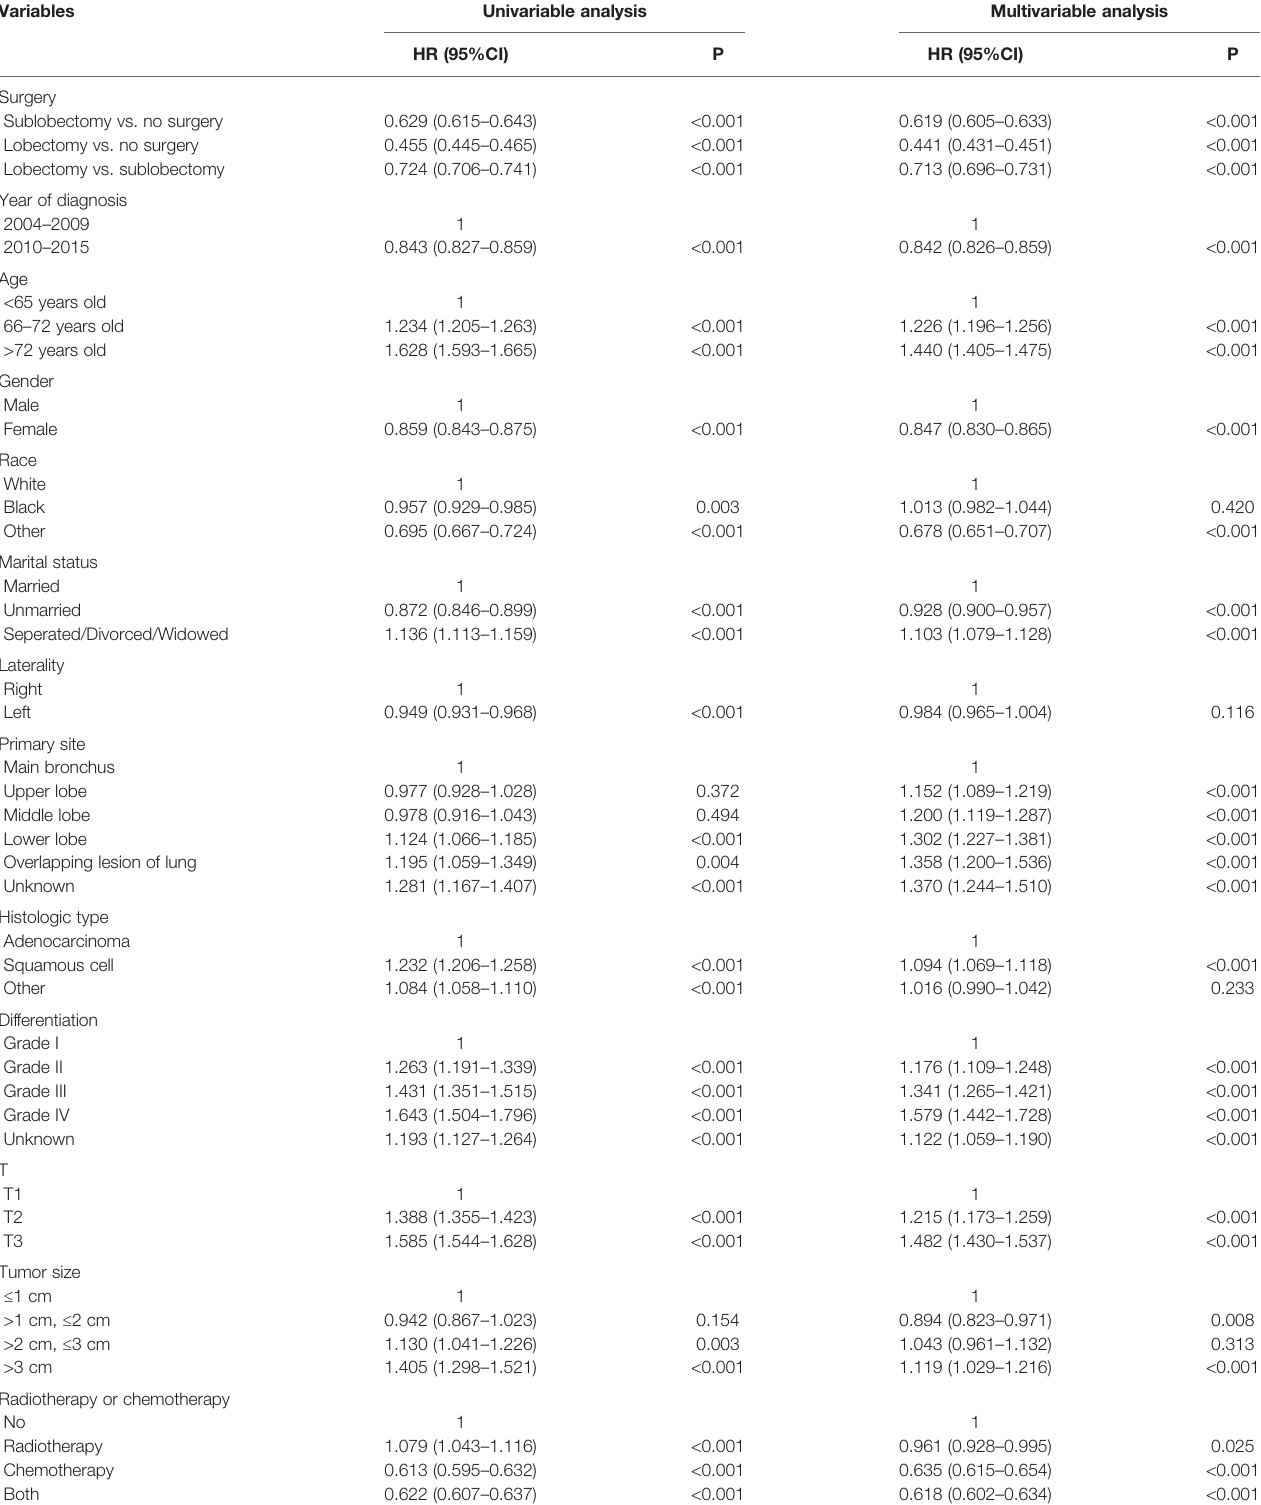
TABLE 3 | Cox regression analysis of all IIIAN2 stage NSCLC patients after